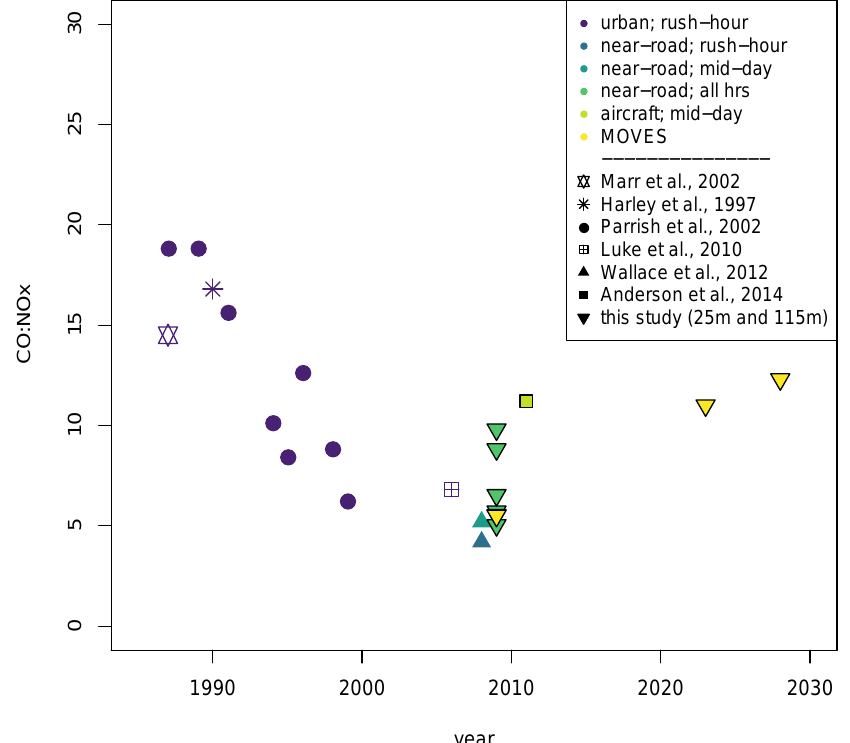
Figure 3. Comparison of regression-based ∆ CO: ∆ NO x in the literature to median values from each method and results from this study (25 m / 115 m monitor distances and MOVES estimates). The symbol indicates the study from which each datapoint is derived. The colors indicate the type of measurement location and the time-of-day for the